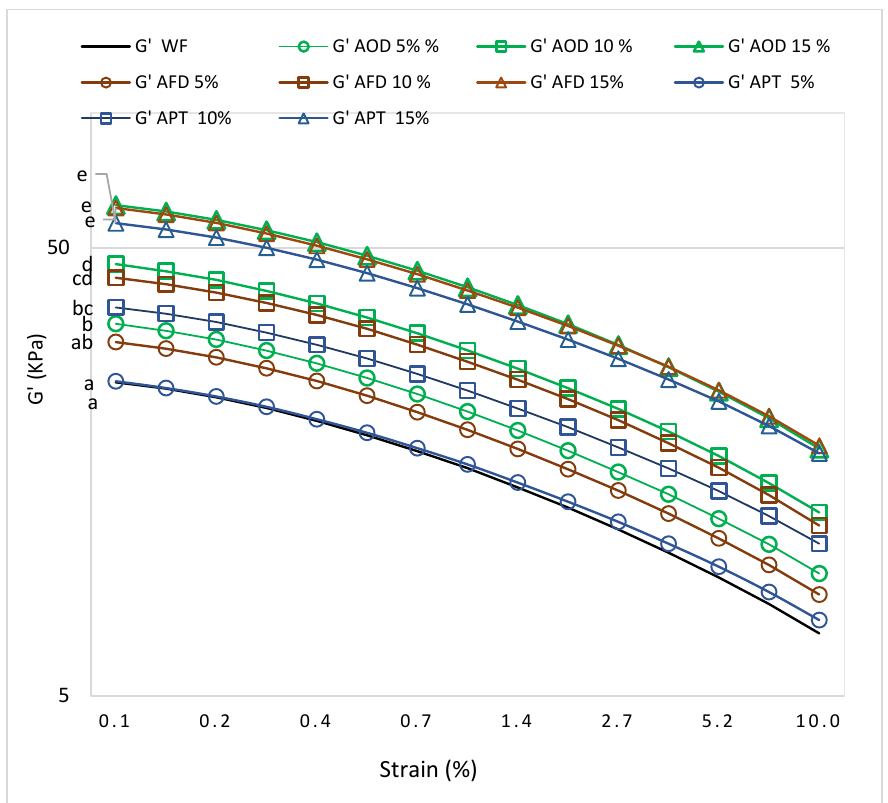
Figure 2. Elastic module (G’) as a function of strain obtained in dynamic oscillatory test. Results are presented as mean of three replicates. Different letters indicate statistically different values ( p < 0.05). WF = Wheat flour; AOD = A. domesticus oven dried; AFD = A. domesticus freeze dried; APT = A. domesticus paste.